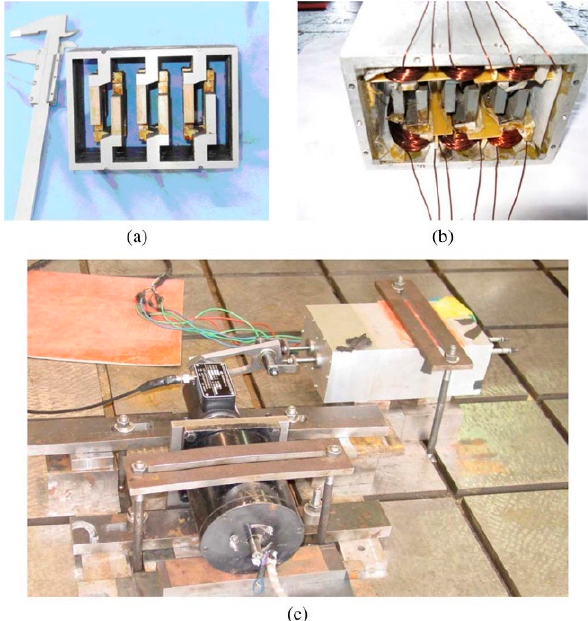
Figure 9. Pictures of the prototype machine and test bench [34]. ( a ) Stator core; ( b ) Stator windings; ( c ) Test bench.